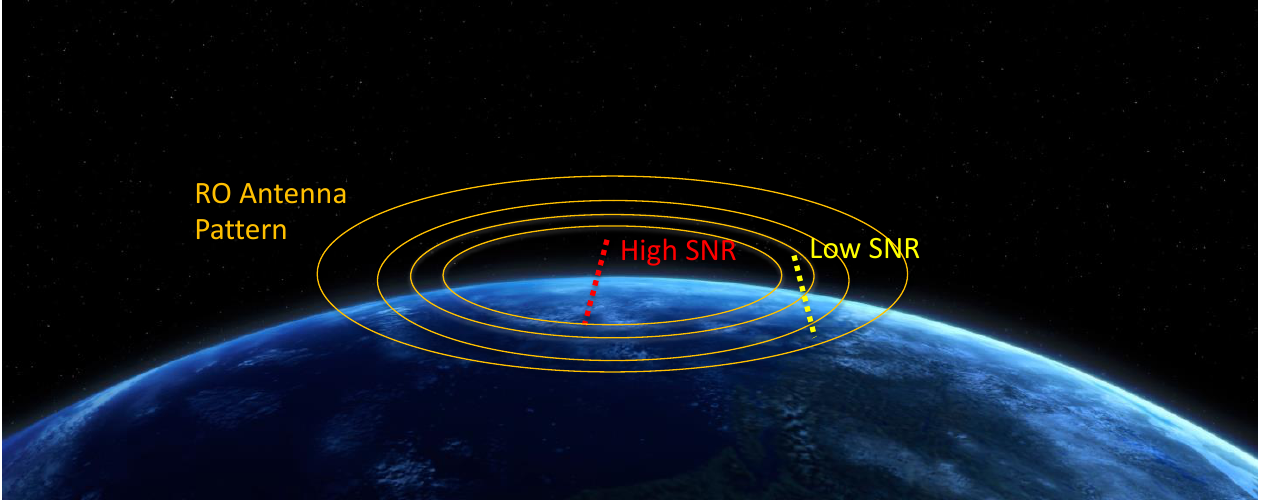
Figure A1. GNSS-RO SNR variations with respect to a typical RO antenna pattern. The dotted lines denote occultation events, but their vertical extent is exaggerated slightly to help with illustration.